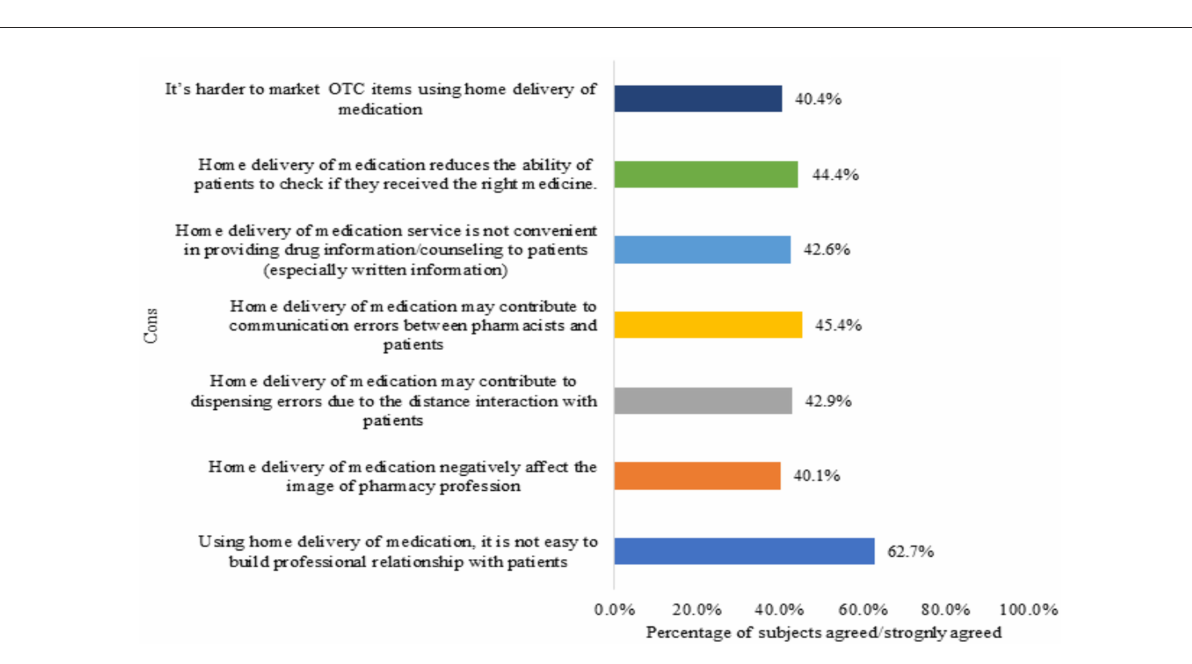
FIGURE2 Participants’ perception of the cons of home delivery of medication service ( n =